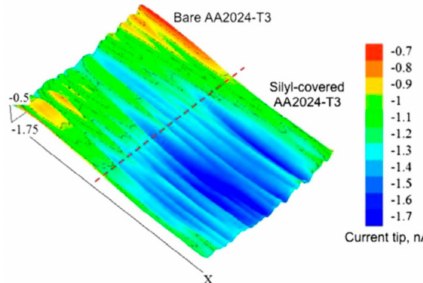
Figure 14. Scanning electrochemical microscopy (SECM) profile of the transition area on aluminium Alloy with control and silyl-treated coatings immersed in 0.05 M NaCl solution for 1 day. Adapted from [69], with permission from © 2011